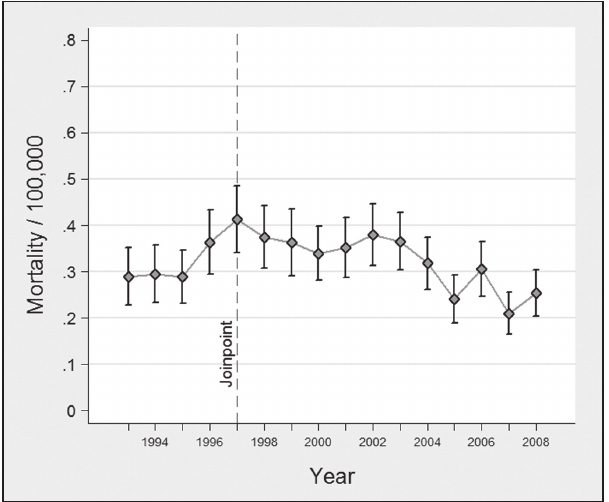
Figure 2) Annual mortality rates for ischemic colitis patients requiring colectomy in the United States between 1993 and